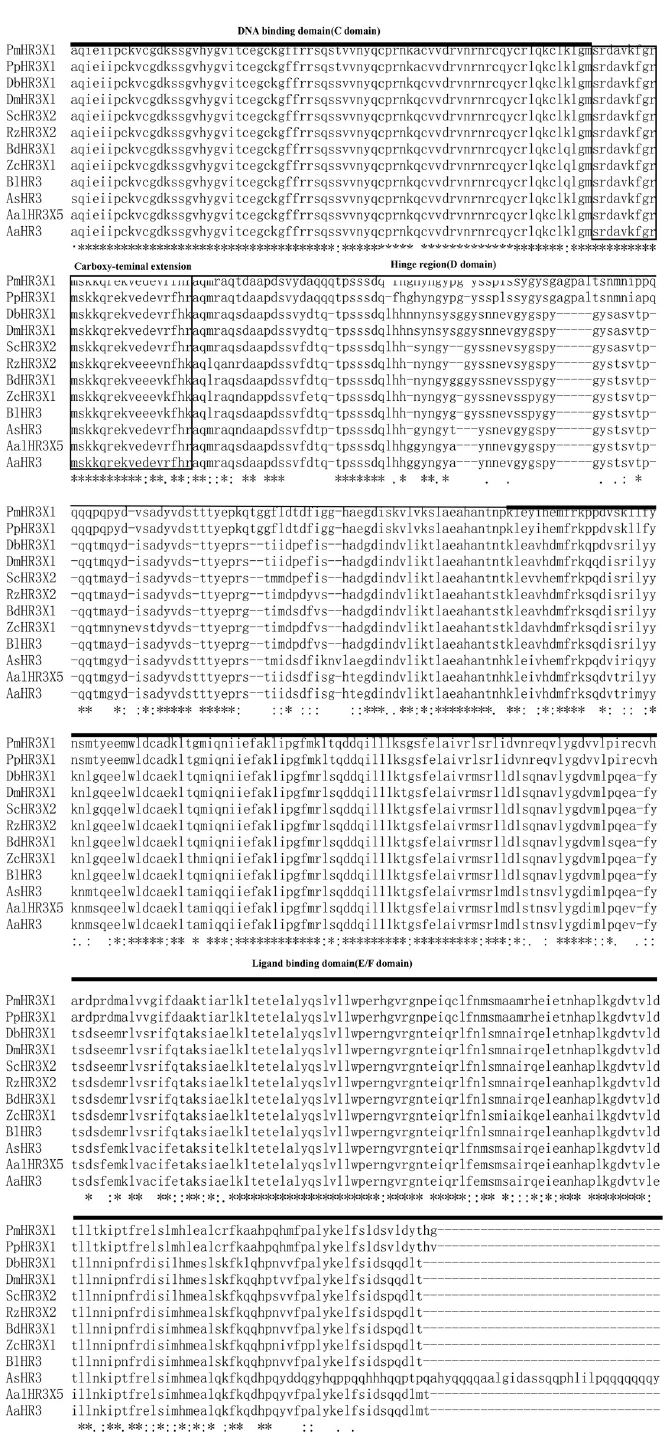
PLOS ONE | https://doi.org/10.1371/journal.pone.0240223 October 14, 2020 6 /